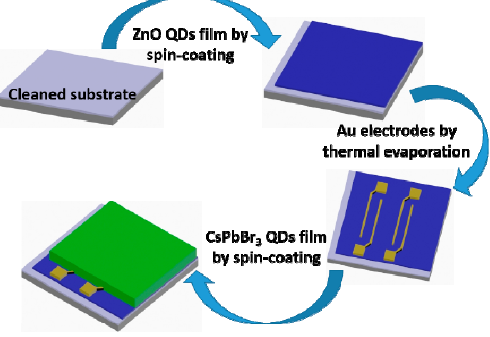
Figure 3. Fabrication steps of the phototransistor.